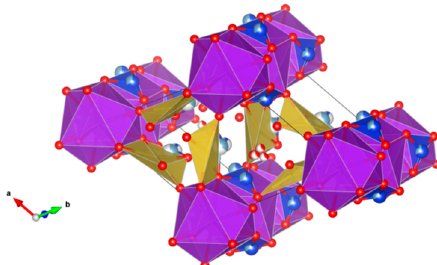
Figure 18. Nepheline/Leucite. (Na, K)AlSiO 4 /K[AlSi 2 O 6 ]. Structure hexagon., Sp. gr. P6 3 /tetragonal, Sp. gr. I4 1 /a and I4 1 /acd or cubic, Sp. gr. Ia3d. Cations can be Li, Na, K, Rb,